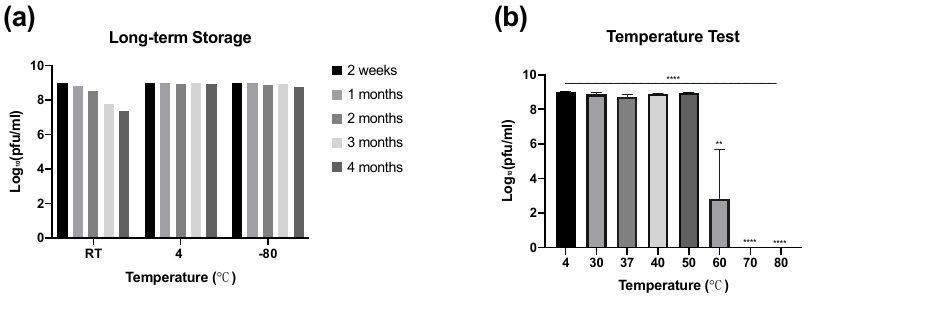
Figure 3. Stability Test for APTC-EC-2A. Graphs (log10 pfu/mL) showing the ( a ) long-term storage stability of phage APTC-EC-2A at room temperature, 4 ◦ C and − 80 ◦ C for up to 4 months, ( b ) phage thermal stability at temperatures ranging from 4 ◦ C to 80 ◦ C, ( c ) phage pH stability test with pH ranging from pH = 3 to pH = 12. Significance was determined by one-way ANOVA with Dunnett’s multiple comparisons post-hoc test. Bars represent standard deviation (SD). **, p <0.001; ****, p < 0.0001. RT = room